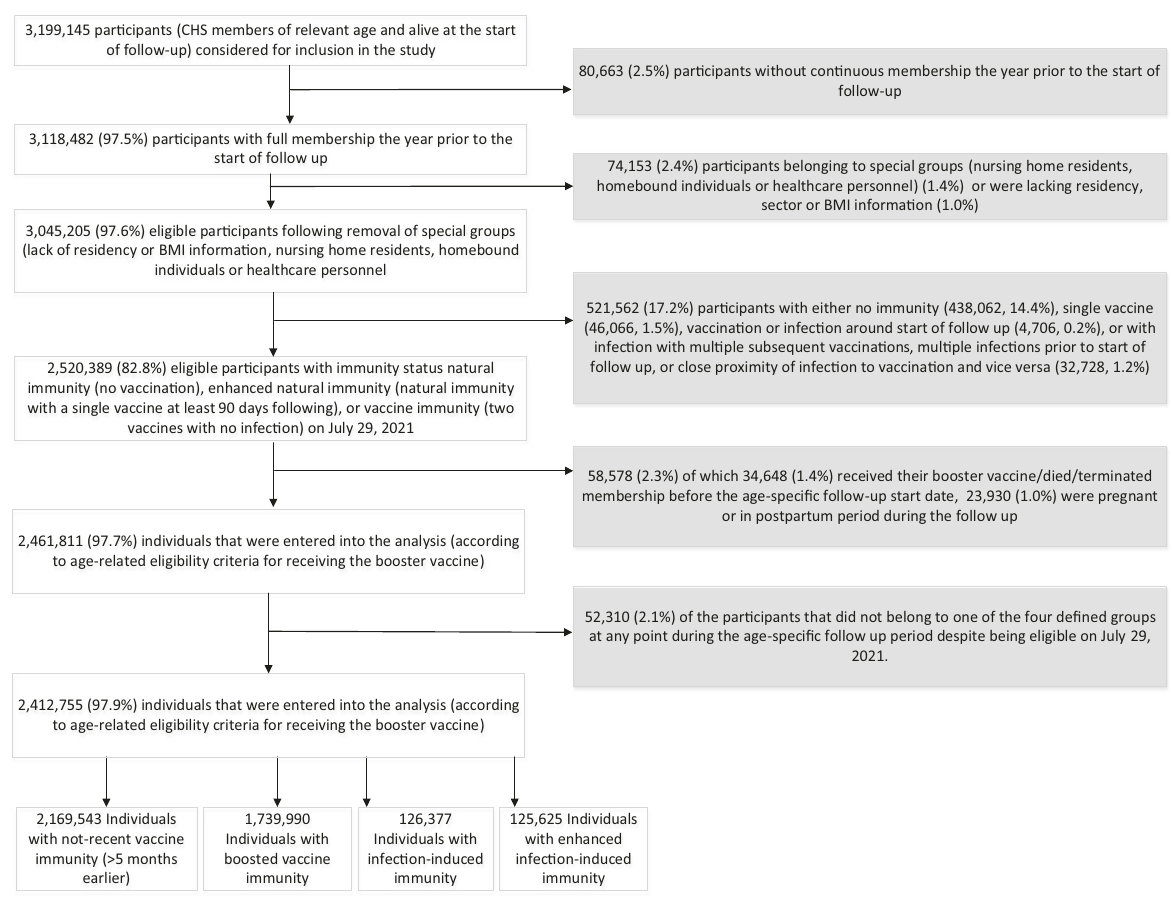
Fig. 1 Study population fl ow chart. Size and percentage change of study population resulting from each inclusion and exclusion